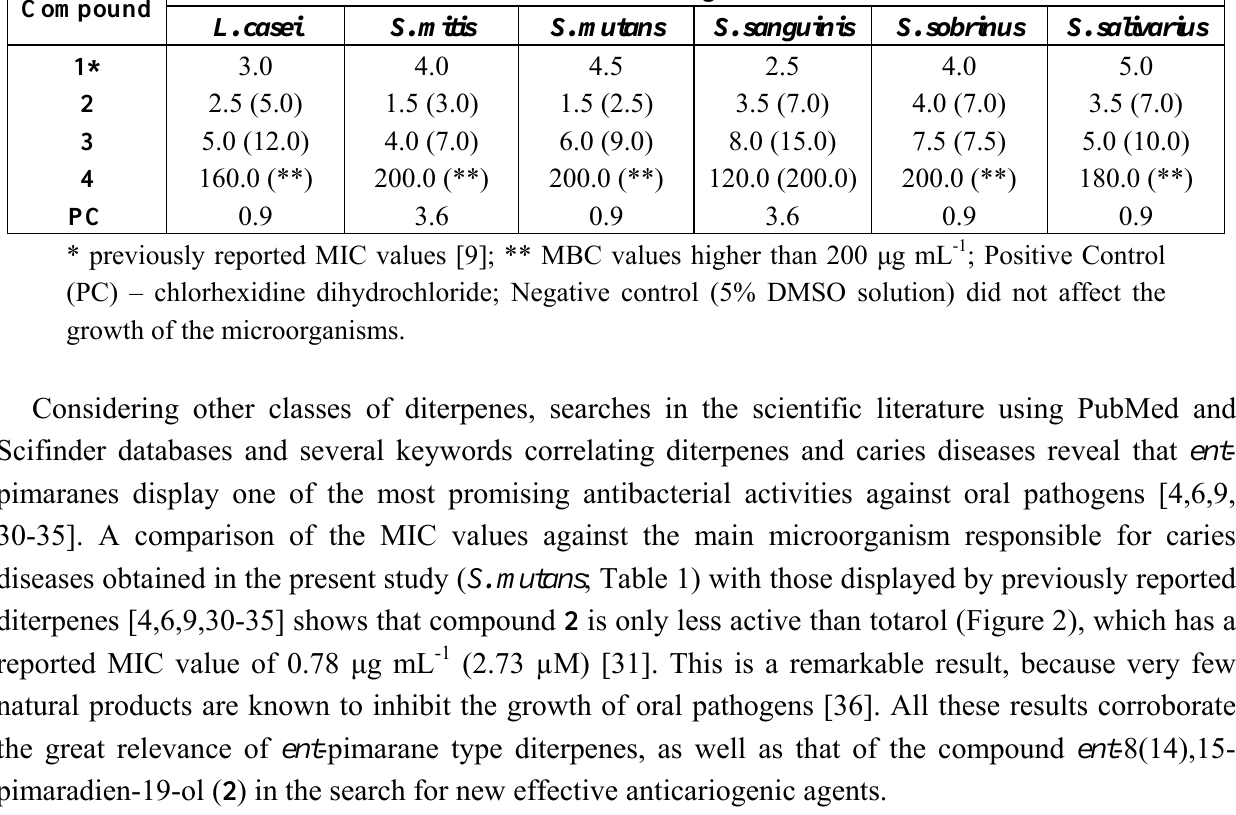
Table 1. In vitro antibacterial activity (Minimum Inhibitory Concentration and Minimum Bactericidal Concentration, μ g mL -1 ) of the biotransformed diterpenes against oral pathogens. Microorganism Compound L. casei